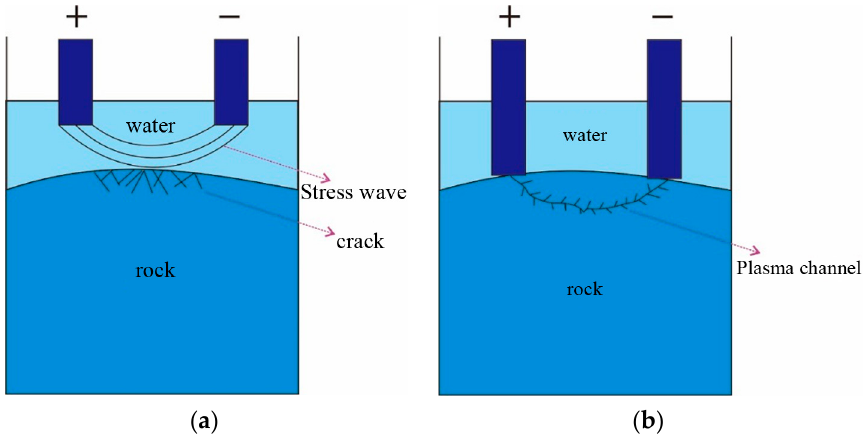
Figure 1. Rock breaking mode by high voltage pulse. ( a ) electrode is not contact with rock; ( b ) electrode is in contact with rock.